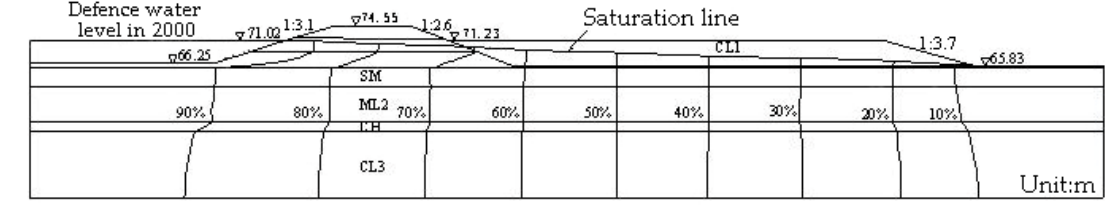
Figure 15. Seepage field potential distribution diagram of typical dike section.